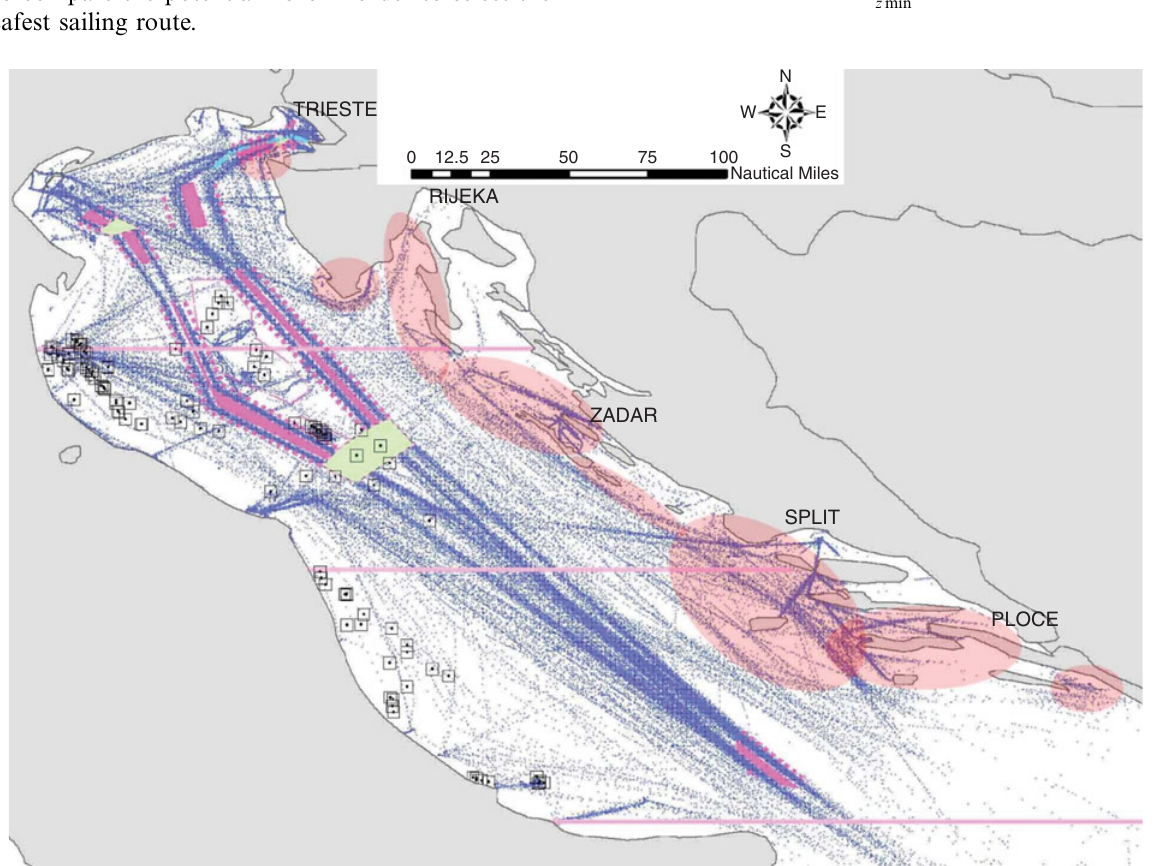
Fig. 2. AIS vessel plotting (2009) and areas of increased grounding risk, Adriatic Sea-Eastern part (Lusˇic´ et al .